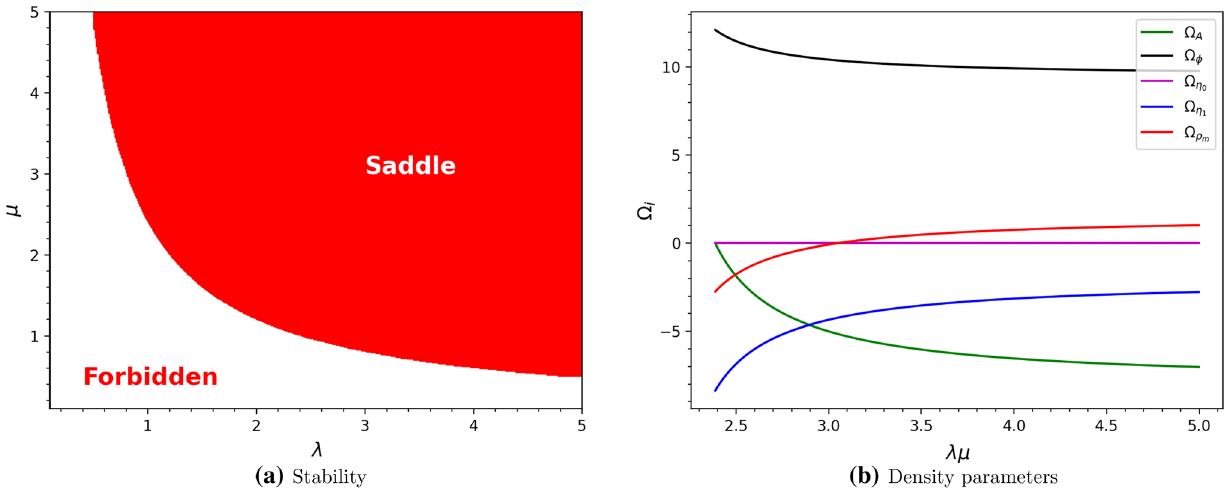
of non-vanishing fields and free parameters, i.e., λ and μ . The green, 2 black, purple, blue and red line in graph b indicates (cid:12) A , (cid:12) φ , (cid:12) η and (cid:12) ρ , m